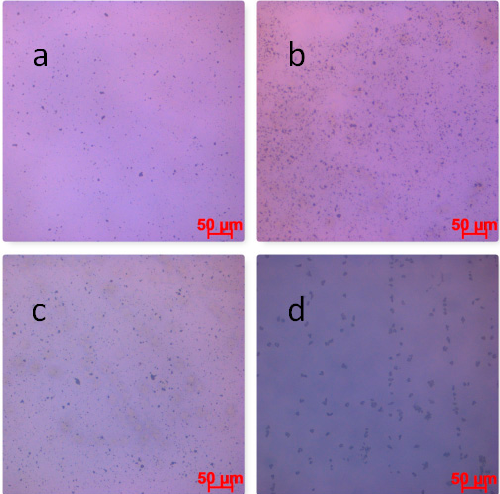
Figure 3. Micrographs of the hydrogel–graphene coupling agent. ( a ) graphene mass fraction is 0.25%, ( b ) graphene mass fraction is 0.5%, ( c ) graphene mass fraction is 0.75%, ( d ) graphene mass fraction is 1%.